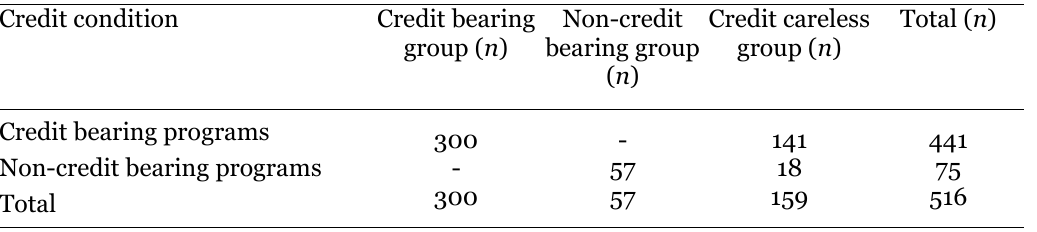
Distribution of Participants According to Credit Condition Credit